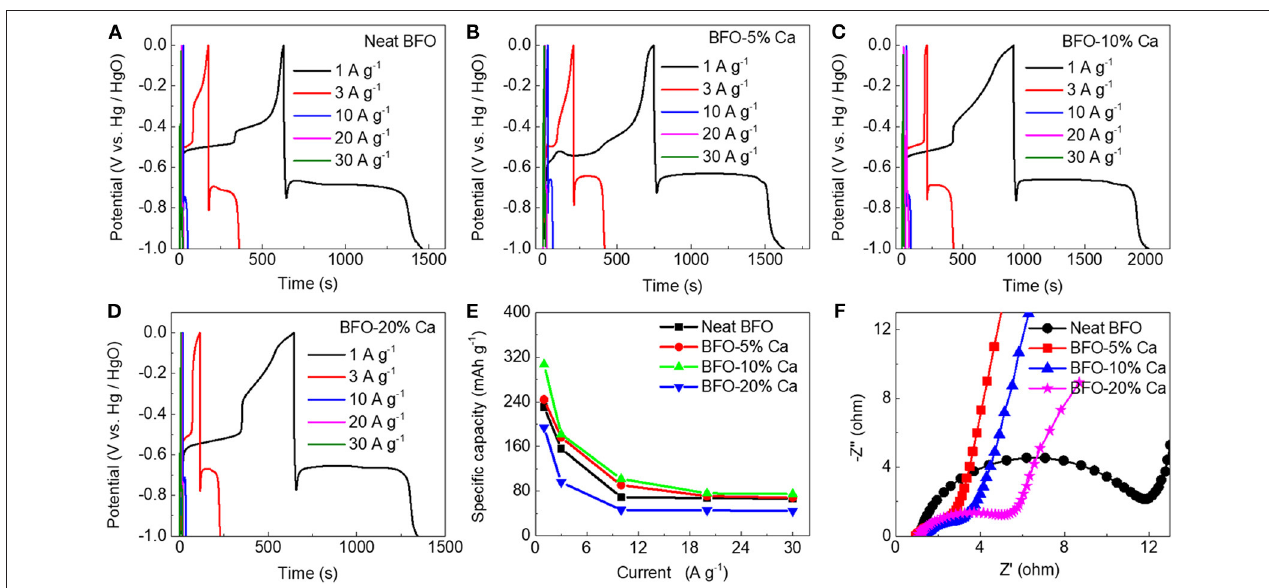
FIGURE 6 | Electrochemical properties of the BFO, BFO-5%Ca, BFO-10%Ca, and BFO-20%Ca powders in a three-electrode system. (A–D) Charge-discharge curves of the four samples at various current densities; (E) the specific capacitance at various current densities; (F) Comparison of EIS curves of BFO, BFO-5%Ca, BFO-10%Ca, and